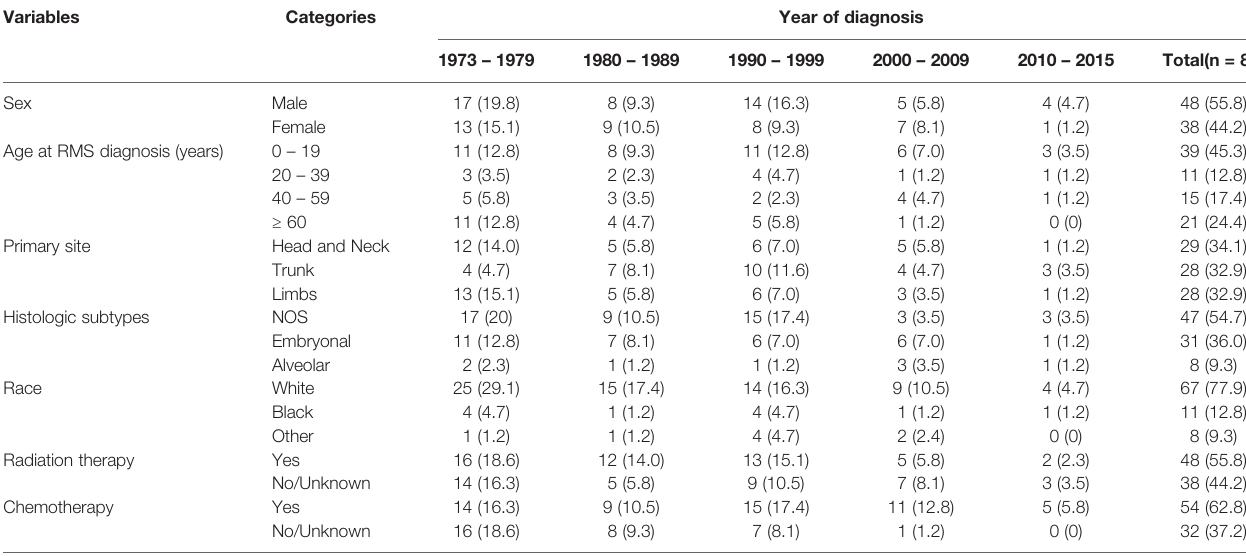
Frontiers in Oncology |